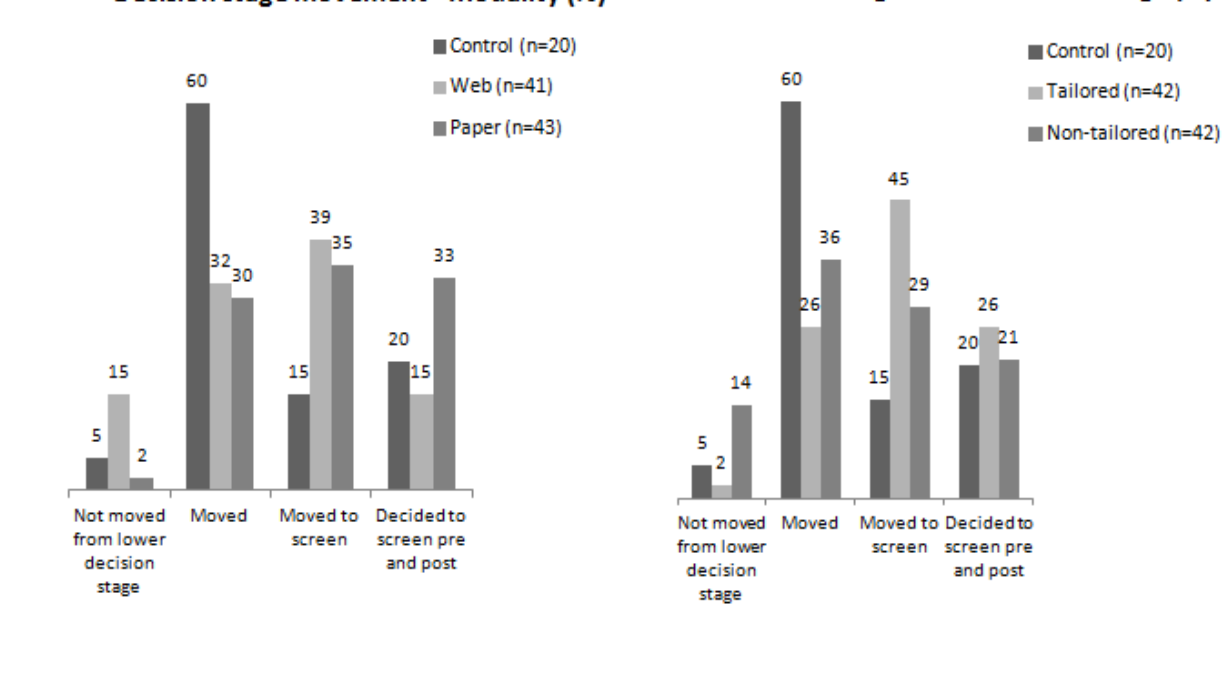
Figure 3. Movement in decision stage post intervention.